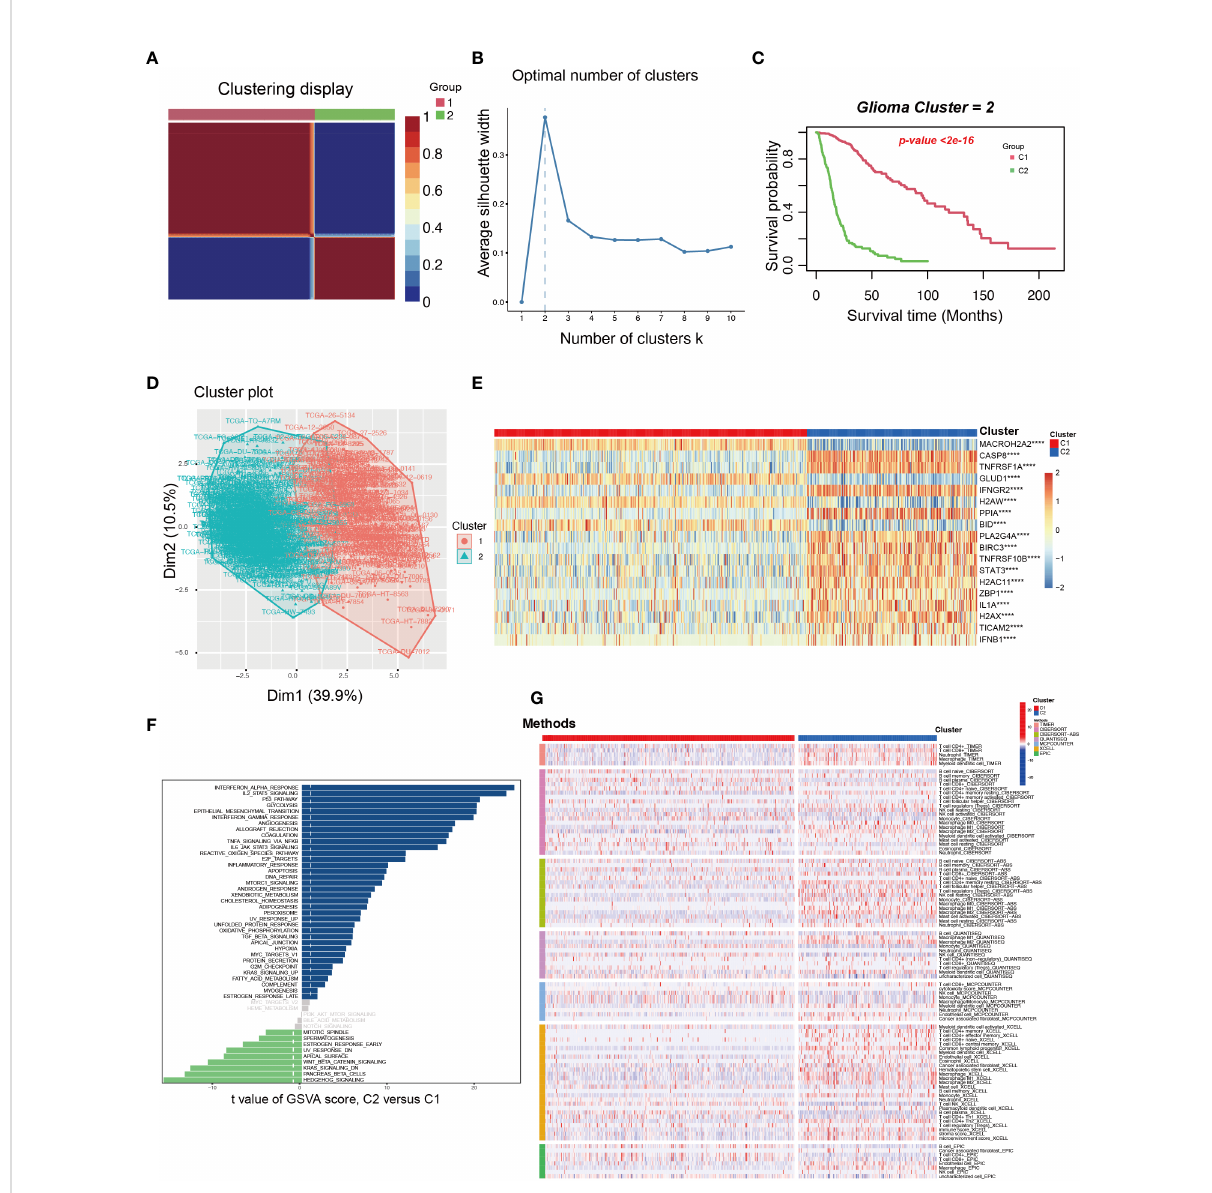
FIGURE 8 The exploration and assessment of two new subtypes in TCGA glioma patients from the 18 NRGs in the present NRS. (A) Based on the CNMF method, the C1 and C2 subtype groups were identi fi ed. (B) When K=2, the silhouette coef fi cient is the highest. (C) The K-M curves showed that the patients in the C1 group had a higher survival probability than the C2 group. (D) PCA analysis illustrated that the two subtypes held different NRGs expression patterns. (E) Heatmap showed the 18 NRGs expression in the two subtypes. (F) The pathway GSVA score of the two subtypes. (G) The heatmap showed 7 algorithms to assess the immune cell in fi ltration between the two subtypes. ****: